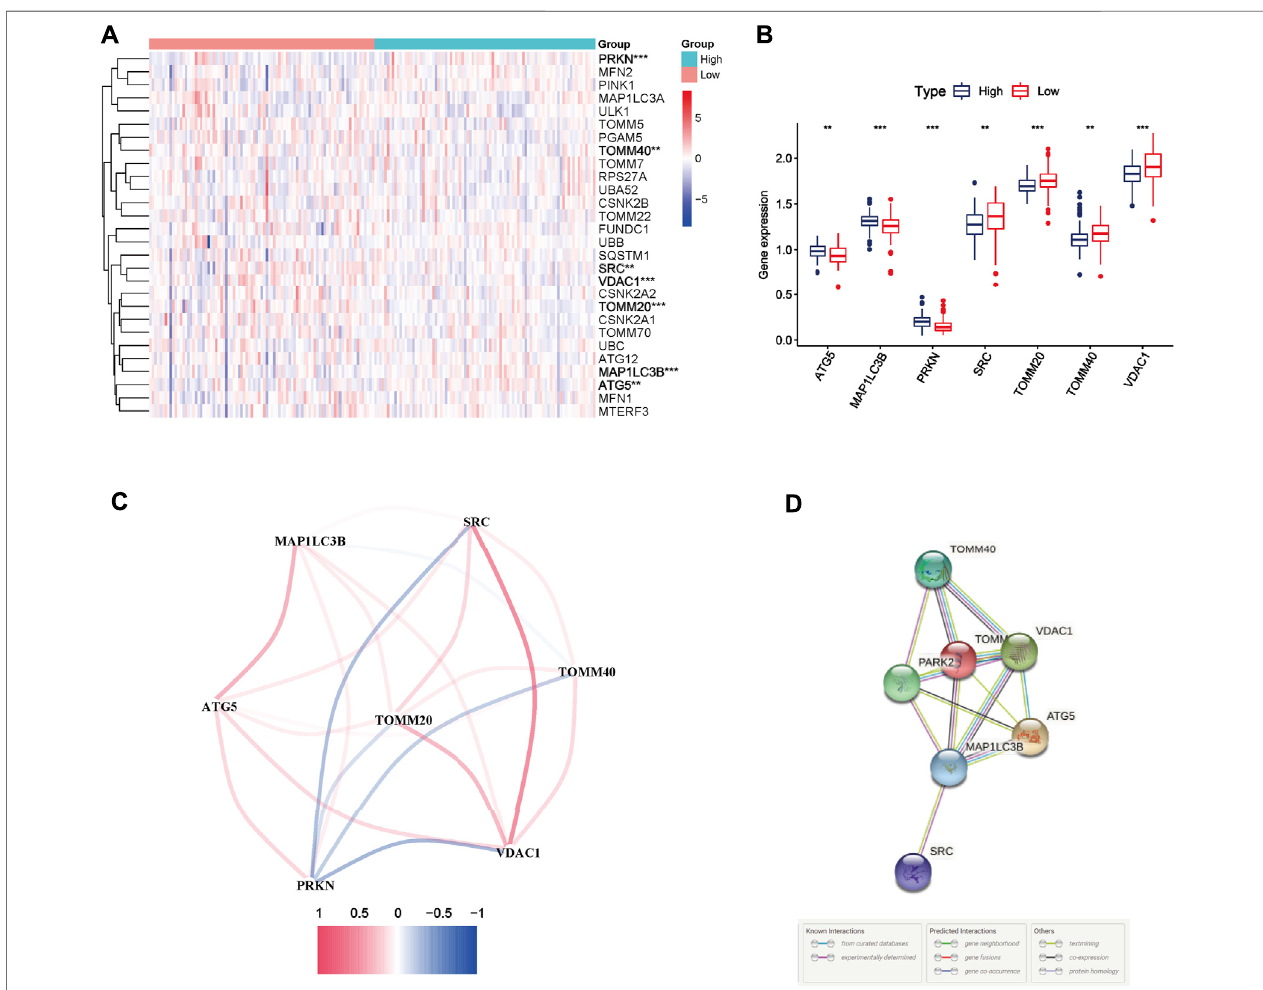
FIGURE1| Mitophagy-relateddifferentiallyexpressedgenes(DEGs)betweentwoimmunesubgroupsinTheCancerGenomeAtlas(TCGA)cohort (A) Heatmapof 29 mitophagy-related genes expression pro fi les between the high and low-immune group of pancreatic cancer patients from TCGA cohort. * represents p < 0.05; ** represents p < 0.01; *** represents p < 0.001 (B) Boxplots of the expression of DEGs (C) Correlation network of DEGs. Red represents positive correlations while blue represents negative correlations (D) Protein-protein interaction (PPI) network of DEGs.